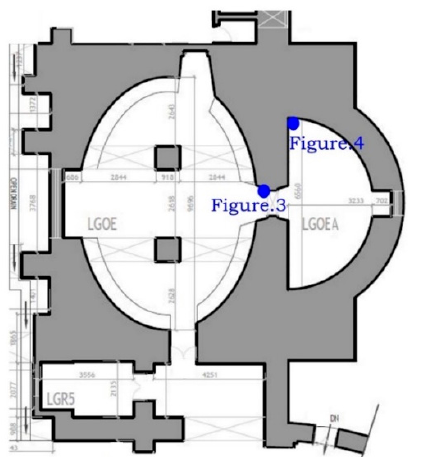
Figure 2. Part of the lower ground floor plan depicting the regions of Figure 3 and Figure 4.